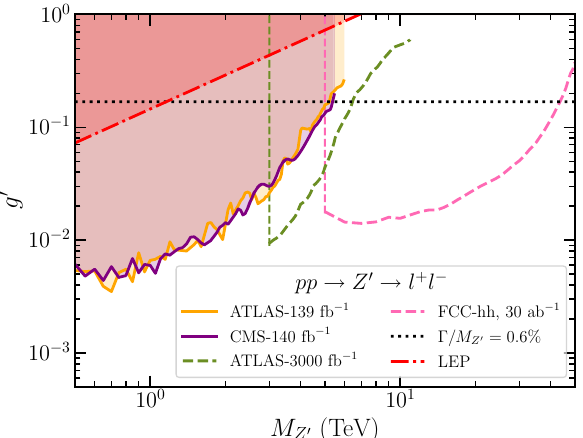
Fig. 1 Limits in the M Z (cid:2) and g (cid:2) plane derived from ATLAS [32], and CMS[33]searches.ThelimitfromLEP-II[34]isshownforcomparison by the red dot-dashed line. The green dashed and pink dashed lines rep- resent the projection for HL-LHC [35] and FCC-hh [36], respectively. The black horizontal dotted line indicates g (cid:2) such that (cid:15)/ M Z (cid:2) = 0 .